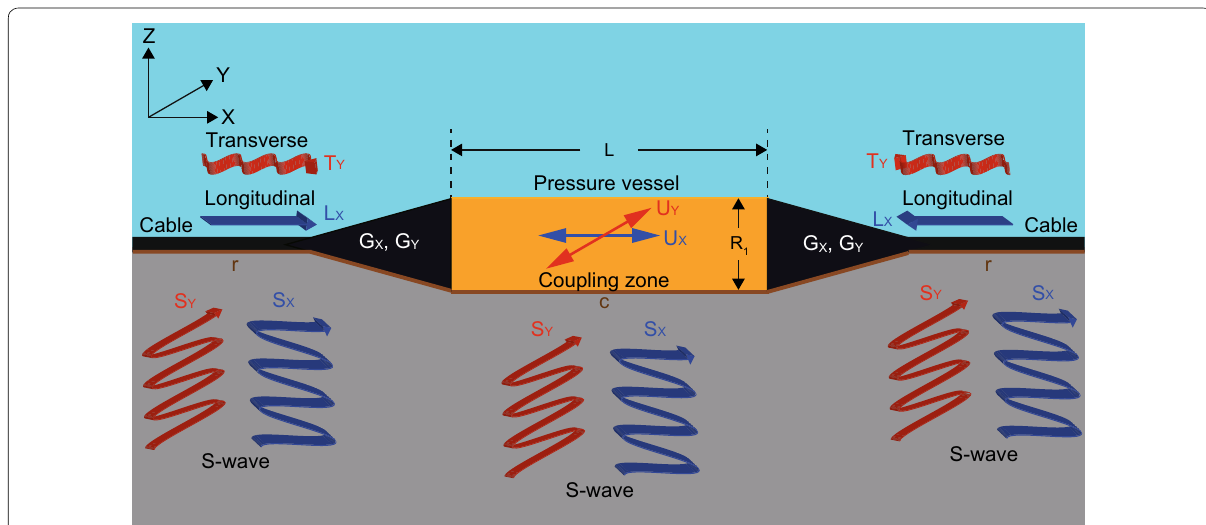
Fig. 11 Schematic illustration of the pressure vessel and cables placed on the seafloor. Some parts of the incident S-waves are directly transmitted into the pressure vessel and some parts are converted into guided waves (transverse and longitudinal waves). These waves vibrate the pressure vessel and excite motions U X and U Y